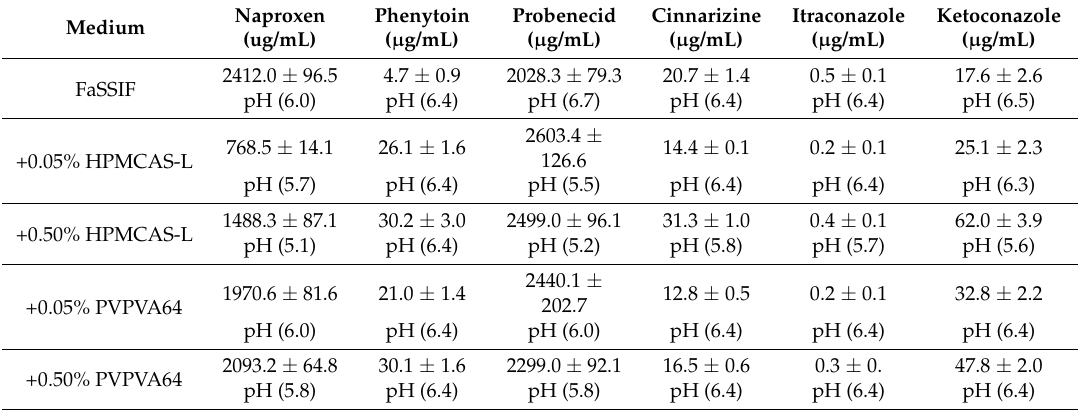
Table A3. Solubility of drugs in fasted state simulated intestinal fluid (FaSSIF) in absence and presence of either hypromellose acetate succinate L-grade (HPMCAS-L) or vinylpyrrolidine-vinyl acetate copolymer (PVPVA64) together with final pH values of the respective